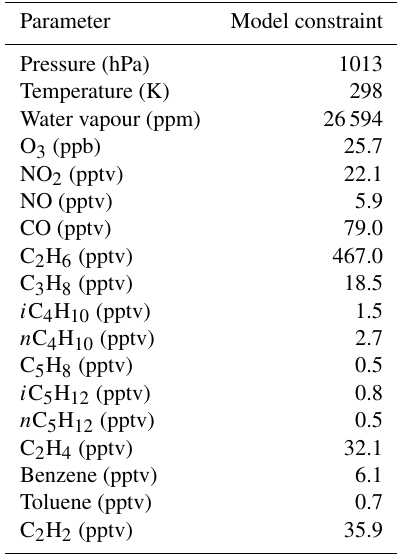
Table 2. Conditions used to constrain the model run to demonstrate the downwind impact on glyoxal of remote monoterpene sources. Mixing ratios are the midday mean values of all data during both ORC 3 measurement